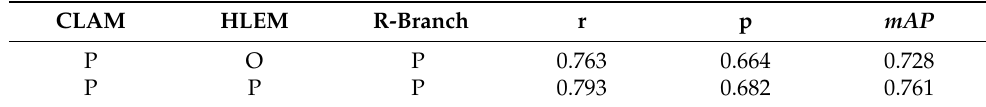
Table 11. Effectiveness of HLEM when the other two modules are